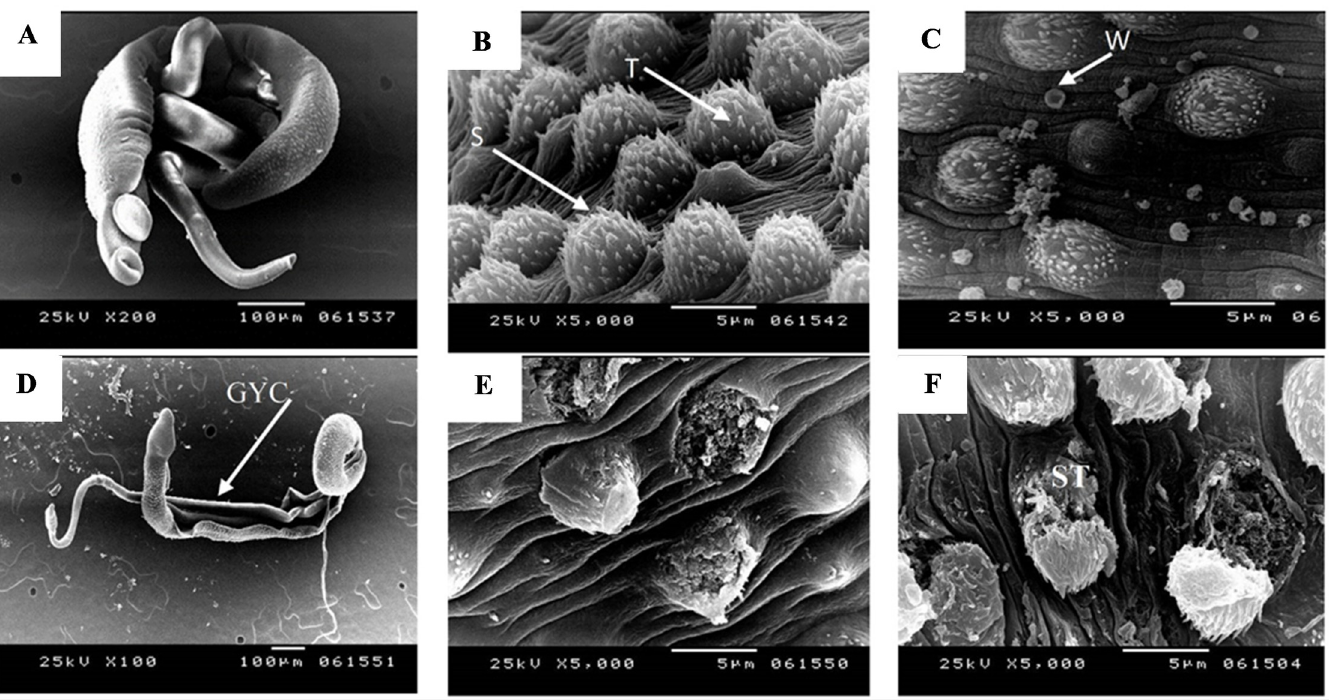
Fig 4. Scanning electron micrographs of adult S . mansoni worms recovered from infected control group (A-B), infected vaccinated group (C-E) and infected vaccinated adjuvanted group (F). (A) Adult couple worms obtained with normal configuration, muscle tone and normal male sucker (X 200). (B) Male dorsal tegument showing uniform size, distribution tubercles (T) and visible spines (S) (X 5000). (C) Dorsal tegument of adult male with white blood cell (W) attached to it (X 5000). (D) Distorted elongated couple with wide gynaecophoric canal (GYC) (X100). (E) Dorsal tegument with variably sized tubercles and complete loss of spines of male worm (X 5000). (F) Adult male worm with sloughing of the dorsal tegumental tubercles (ST) and lost spines (X 5000).